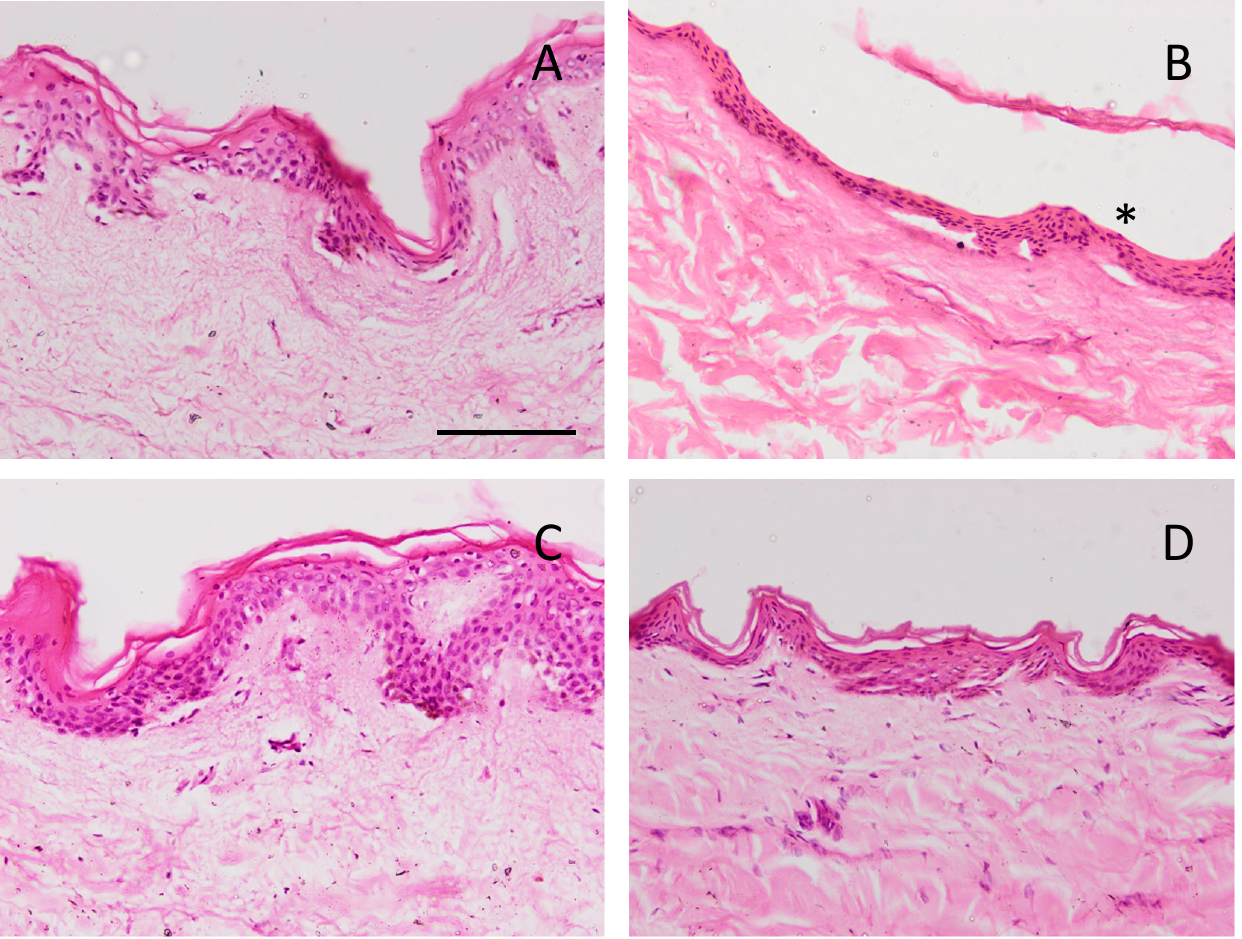
Figure 12. Skin sections stained with hematoxylin and eosin after the ex vivo permeation study, stained and observed under the microscope at 200X. Scale bar = 100 μ m. ( A ) PBS as negative control; ( B ) ethanol as positive control; ( C ) CPF-gel and ( D ) CPF-AZ-gel. Asterisk indicates loss of stratum corneum.